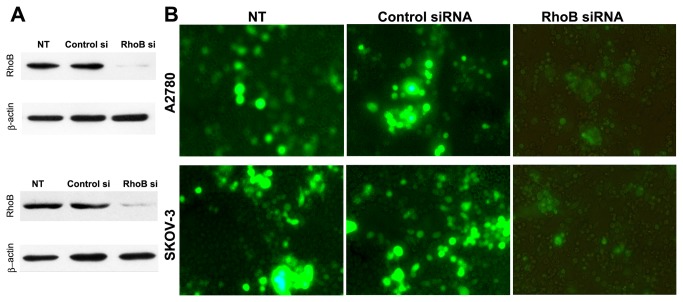
Interference into Revivification of RhoB gene results in inhibition of ovary carcinoma cell apoptosis.After treated with TSA for 24 hours, SKOV3 and A2780 cells were respectively either nu-transfected (NT), transfected with non-targeted Control siRNA (Control si), or with siRNA duplex against human RhoB (RhoB si). (A) The expression confirmation of RhoB by Western blotting analysis with β-actin used as equal loading control: As shown, transfection with RhoB siRNA, but not with Control siRNA, abrogate the protein expression of RhoB. (B) Apoptosis assays of tumor cells after transfection with RhoB siRNA/Control siRNA following treatment with TSA. TUNEL staining of carcinoma cells revealed that RhoB siRNA, yet not Control siRNA, caused a significant reduction of apoptotic cells in contrast to nu-transfected (NT) carcinoma cells.